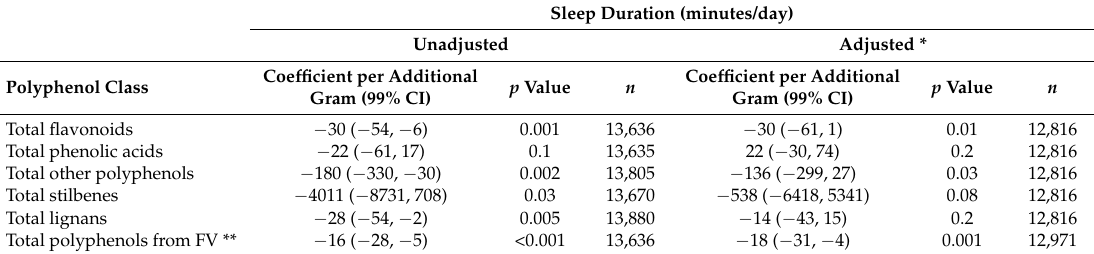
Table 3. The prospective associations between total polyphenols from FV consumption and sleep duration in the UKWCS.